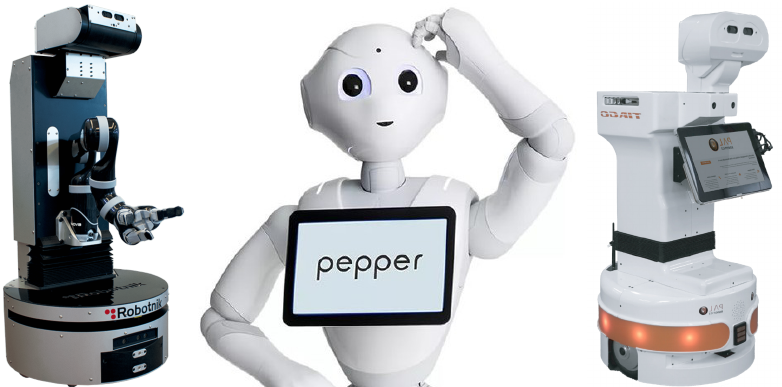
Figure 9. Robots used as testing platform: RB1 ( left ), Pepper ( center ), and TIAGo ( right ).